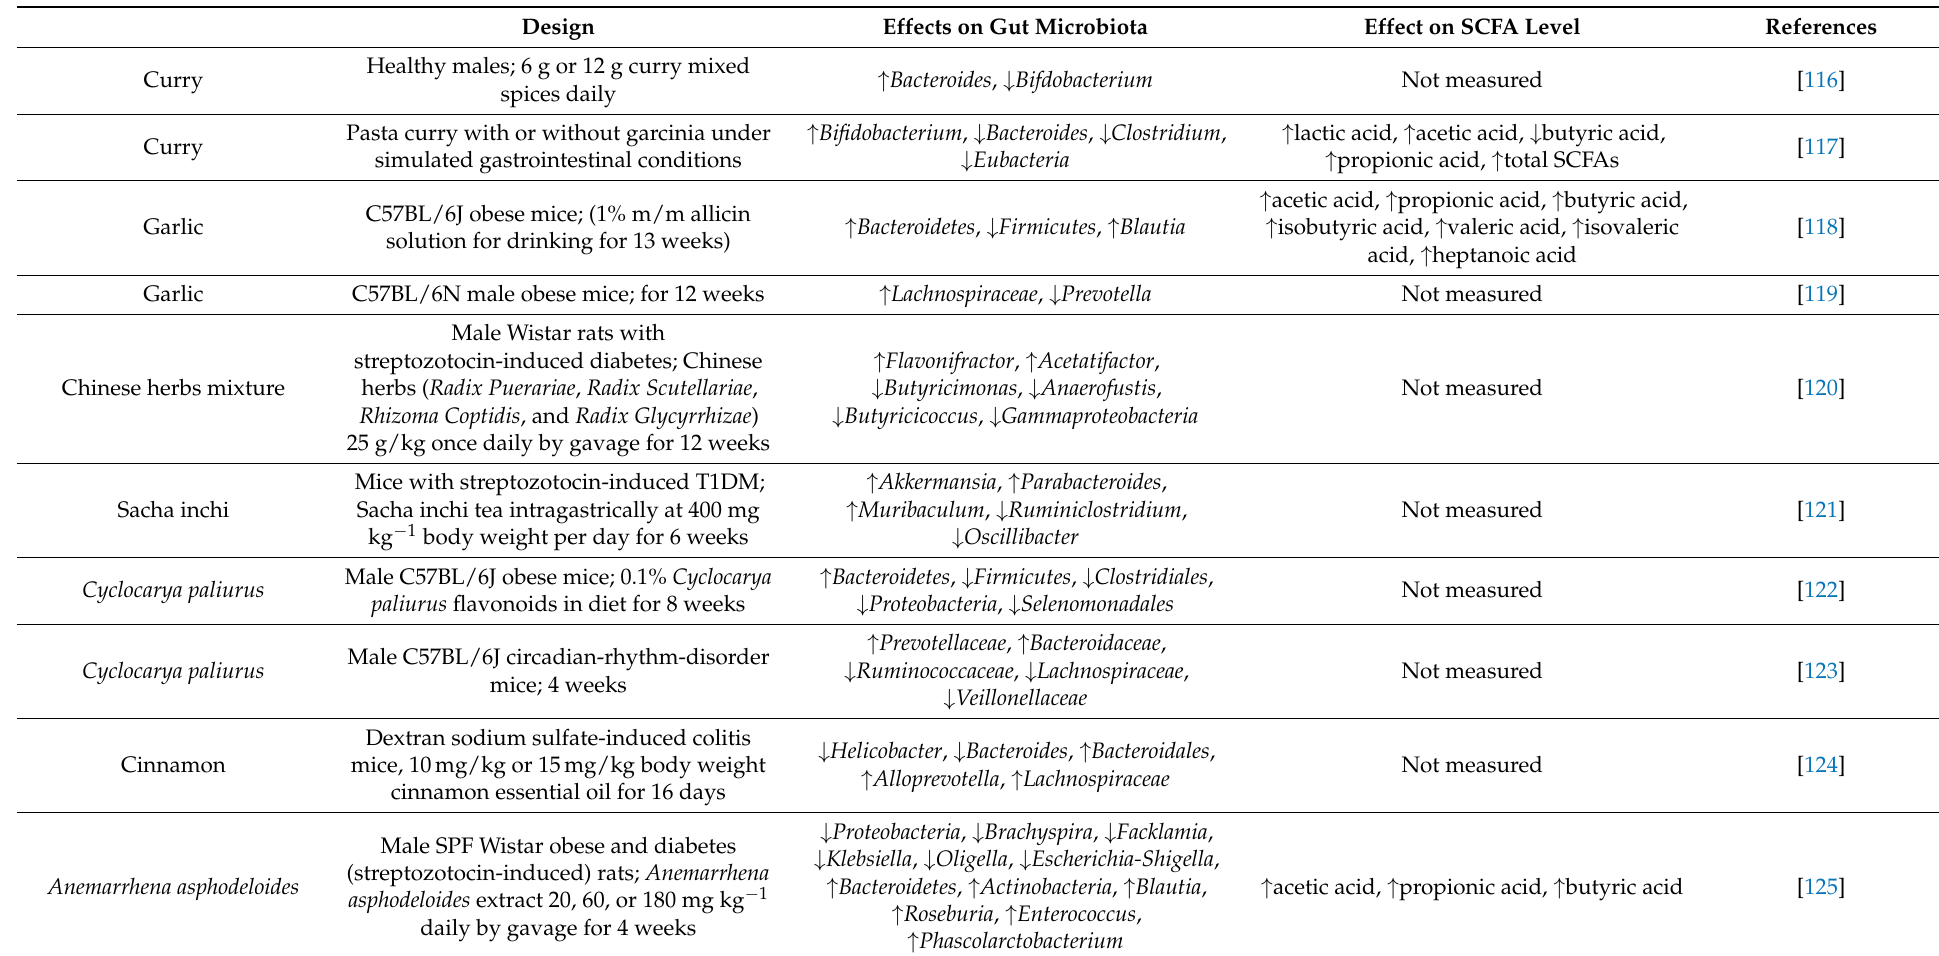
Table 2. Influence of herbs and spices on the microbiota